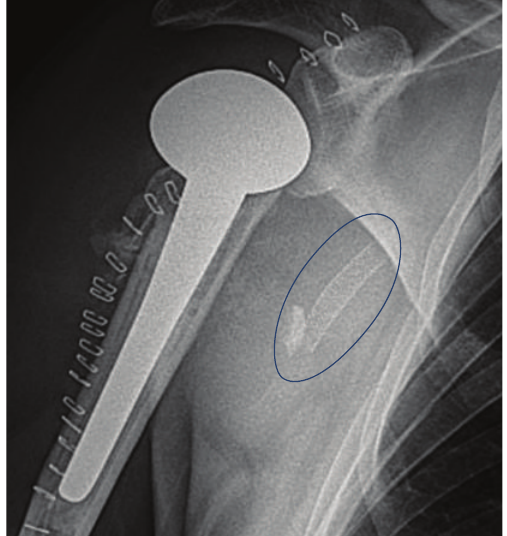
Figure 9: End result after prosthesis and stent implantation (blue oval).